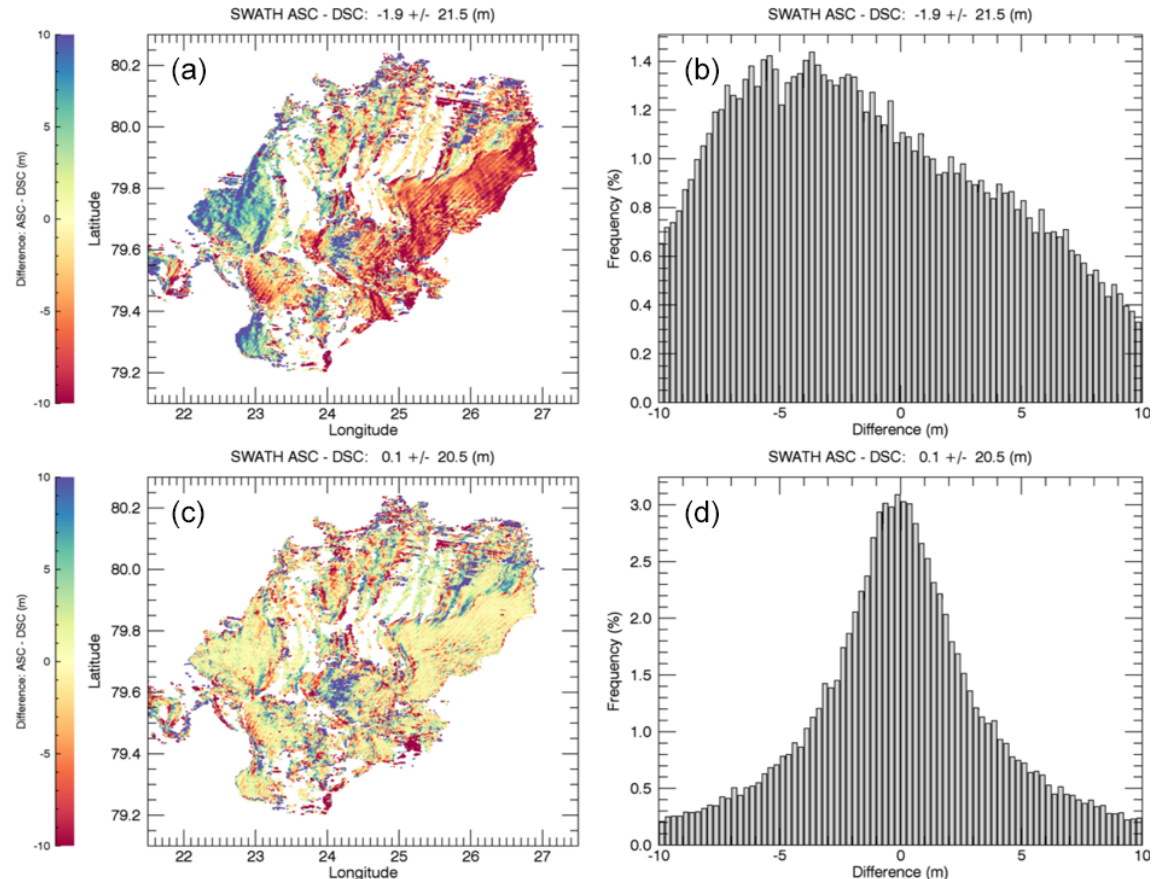
Figure 5. Difference in elevation between ascending and descending swath data at crossovers across Austfonna ice cap. (a, b) Baseline-C + statistics. (c, d) Baseline-D +